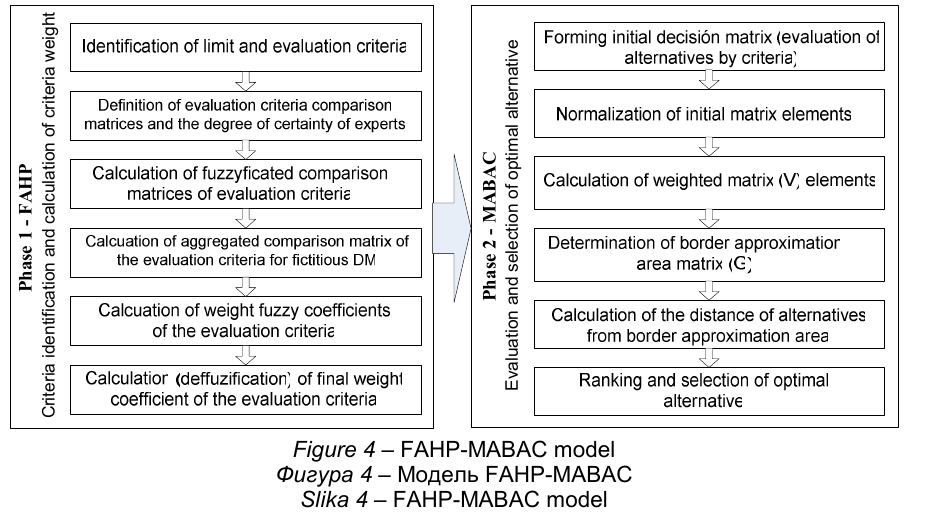
Figure 4 – FAHP-MABAC model Фигура 4 – Модель FAHP-MABAC Slika 4 – FAHP-MABAC